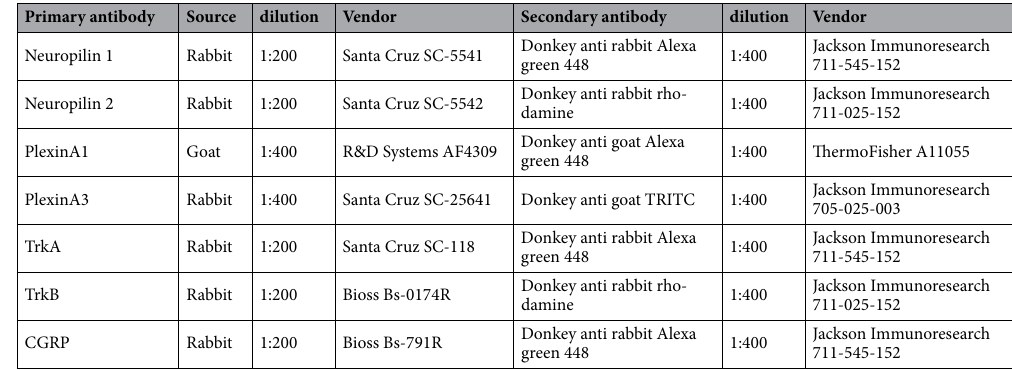
Table 1. Antibodies used for immunofluorescence staining of trigeminal and dorsal root ganglia